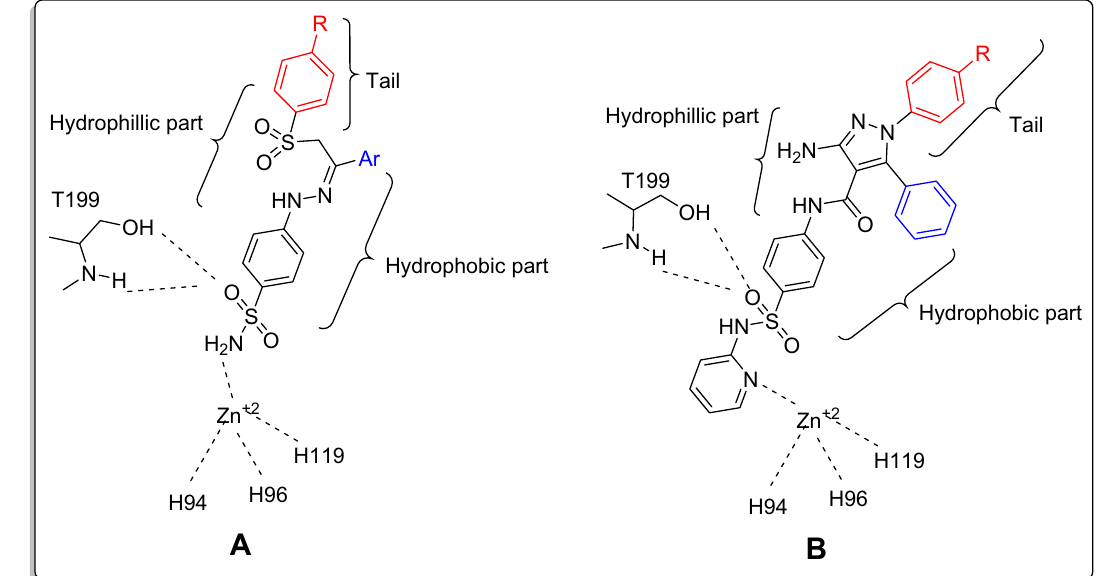
Figure 3. Applying the dual tail concept; ( A ) library designed in literature 35 , and ( B ) The designed target compounds.